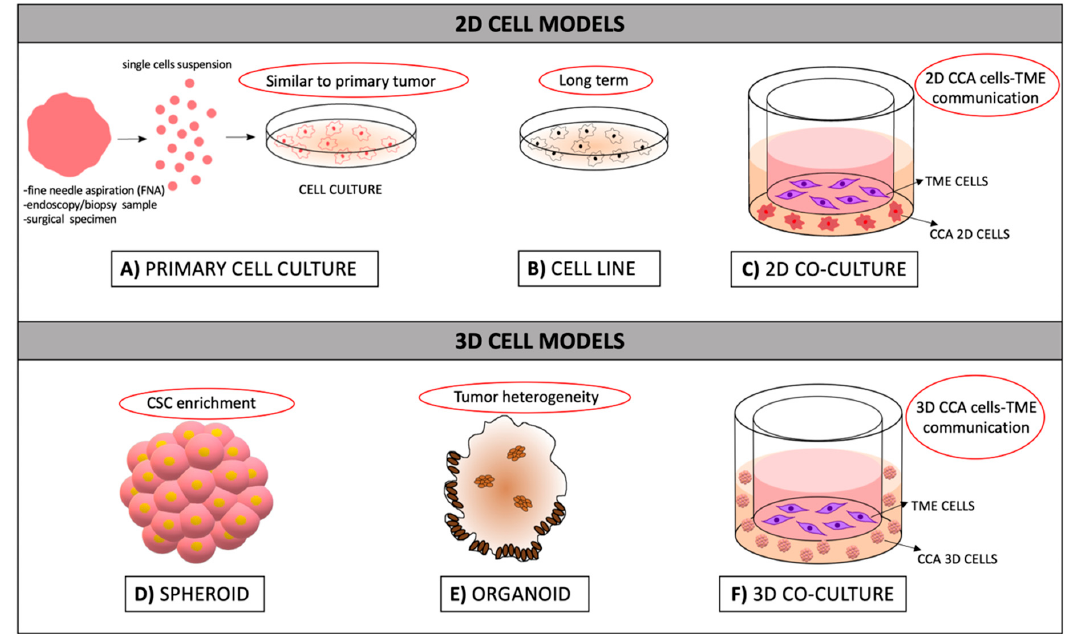
Figure 1. Schematic representation of in vitro experimental models used for investigating CCA. The upper section represents the most common 2D cell models, and the lower section shows the evolution of cell models in 3D cultures. In the red circles there are highlighted the peculiar features of each model. ( A ) Primary cell cultures were derived from surgical specimens mechanically, and enzymatically digested to obtain a single CCA cell suspension. ( B ) Established and characterized in vitro cell line. ( C ) Example of co-culture performed by Transwell assay to allow the crosstalk between tumor cells and TME cells; usually the TME cells are cultured in the upper compartment (e.g., stromal cells) and the CCA cells are plated in the lower compartment. ( D ) Spheroids are 3D floating cultures derived from CCA single cells, enriched in the putative CSC population. ( E ) Organoids are 3D structures with architectures and functions that are similar to in vivo organs; they are established from surgical specimens or biopsies, maintaining the genetic aberrations of the parental tumor. ( F ) Example of co-culture performed by Transwell assay to allow the crosstalk between 3D tumor cells, such as CCA spheroids and TME